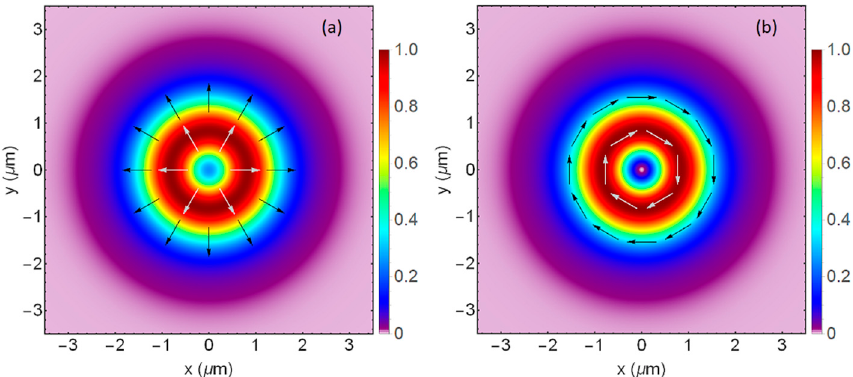
Figure 4. Radially polarized focal spot ( a ); azimuthally polarized focal spot, generated by variation 1A ( b ).